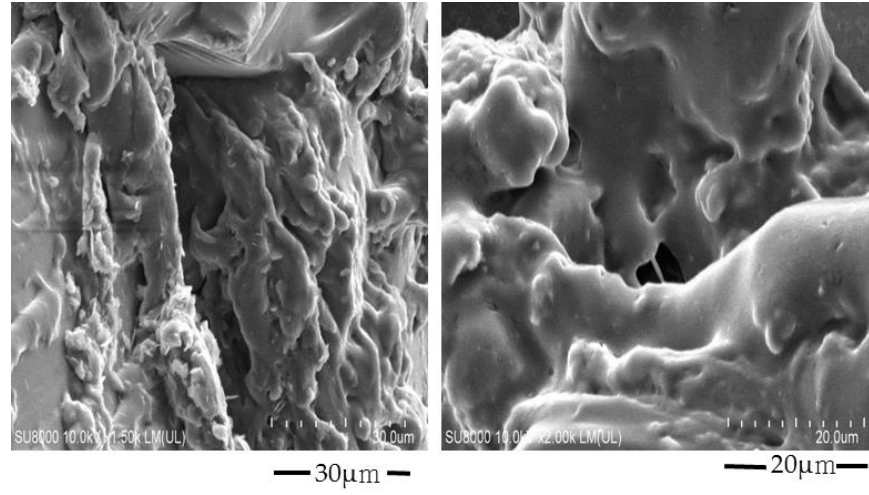
Figure 4. Scanning electron microscopy of the Car934-g-poly(acrylic acid) hydrogels.